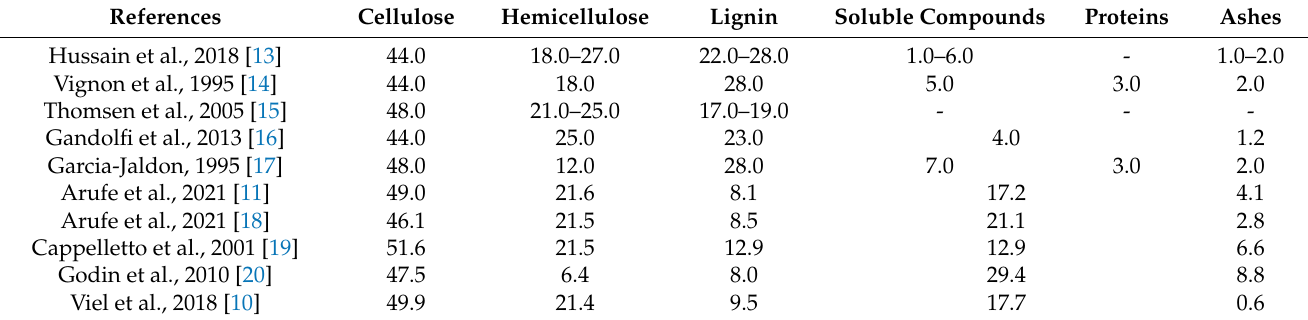
Table 1. Hemp shiv chemical composition according to the bibliography and expressed in percentage (% w / w dry mass). Cellulose Hemicellulose Lignin Soluble Compounds Proteins Ashes Hussain et al., 2018 [13]